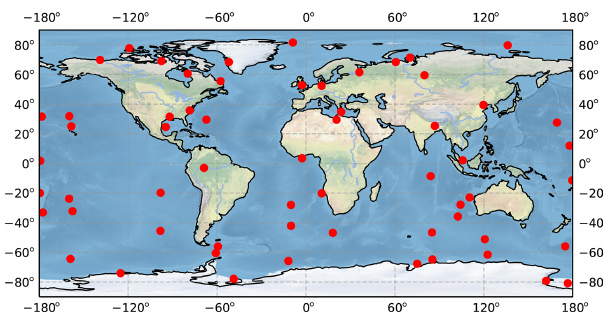
Figure 1. Locations of 60 atmospheric profiles with different sce-